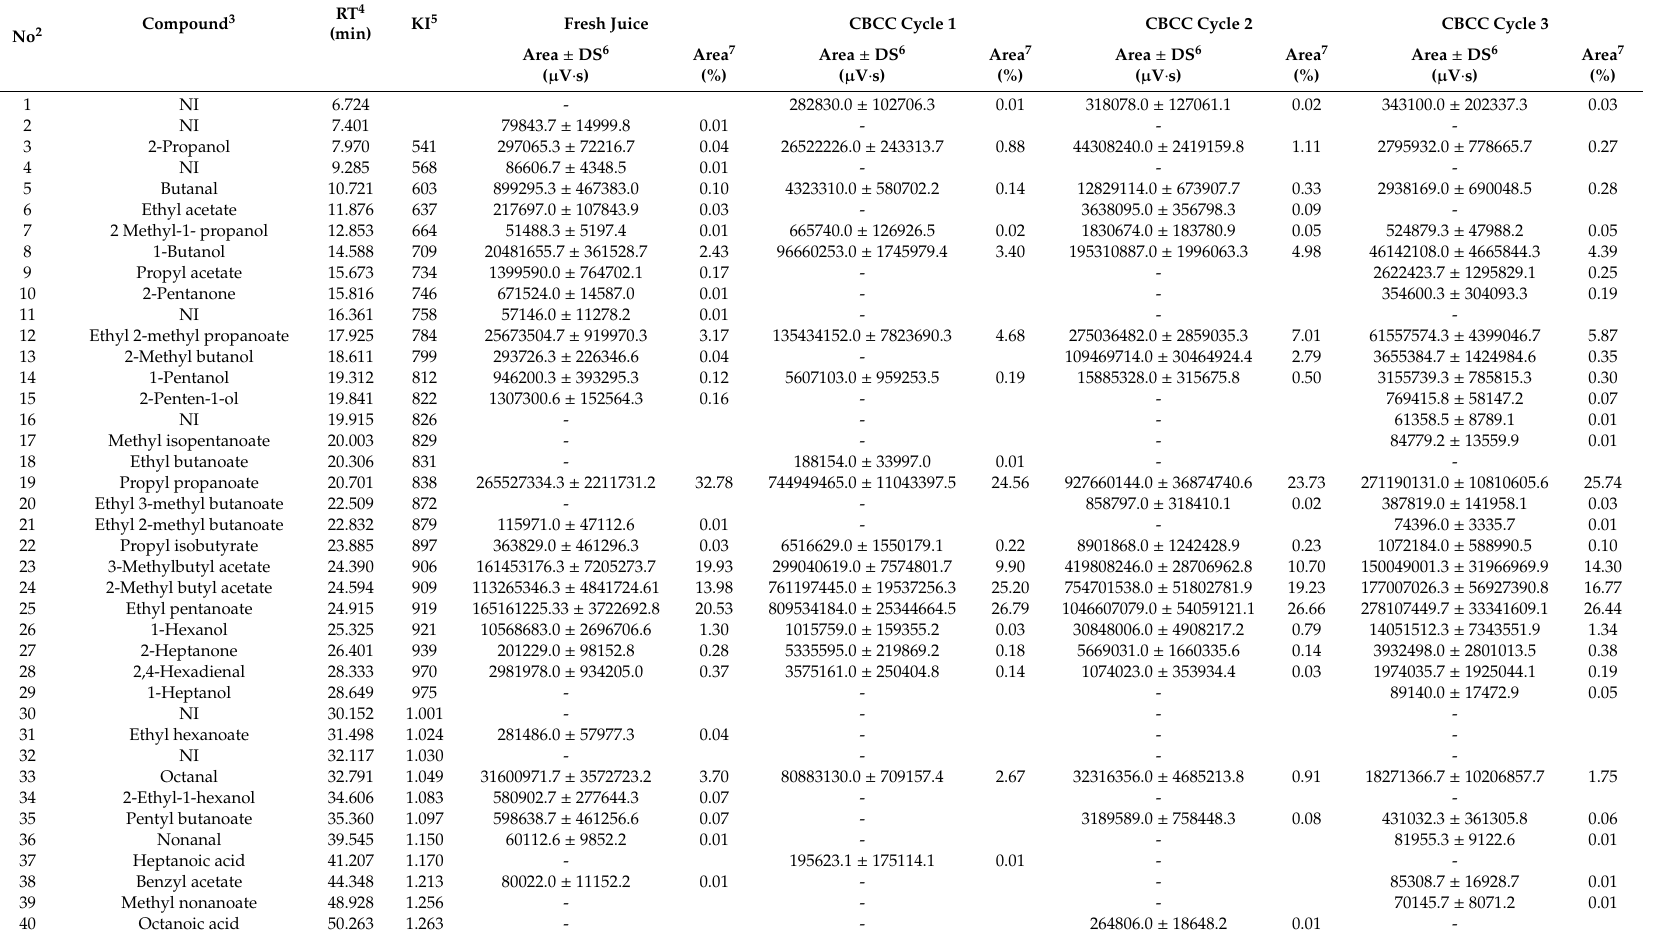
Table 3. Volatile profile of fresh juice and cryoconcentrated samples at each cycle 1